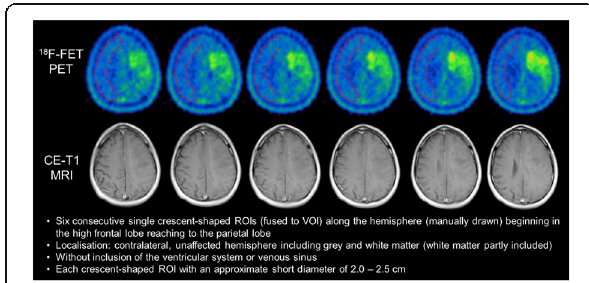
Fig. 3 Instruction for the guided, crescent-shaped VOI